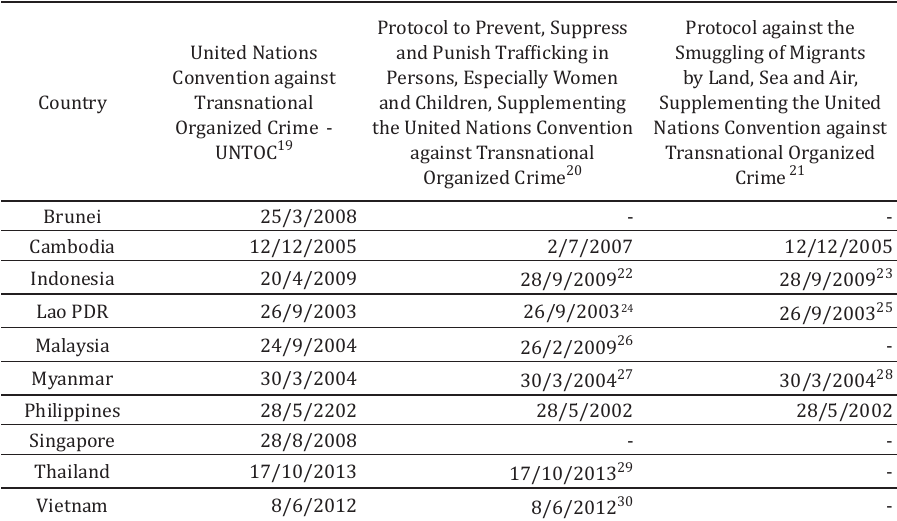
Table 2: Multilateral Mechanisms: UNTOC and its